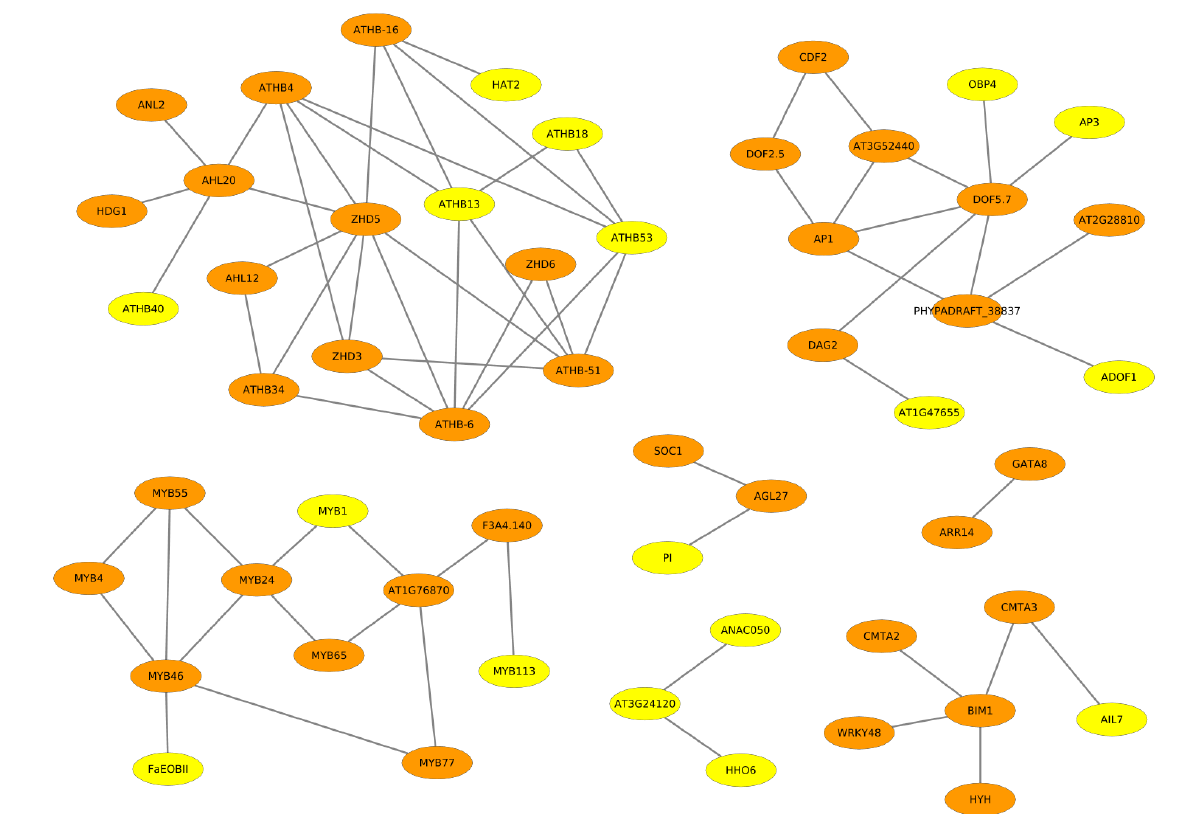
Figure 3. Cooperation network of TF pairs identified for the double high accession ZY821 cultivar. The orange shaded nodes represent the overlapping TFs between ZS11 and ZY821, whereas the yellow shaded nodes represent the TFs that are unique for the ZY821